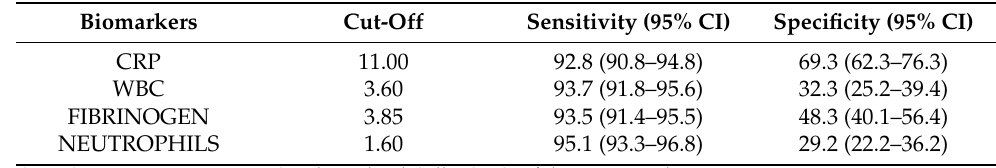
Table 5. Biomarkers’ cut-offs with corresponding sensitivity and specificity. Cut-offs were obtained maximizing the percentage of correctly classified